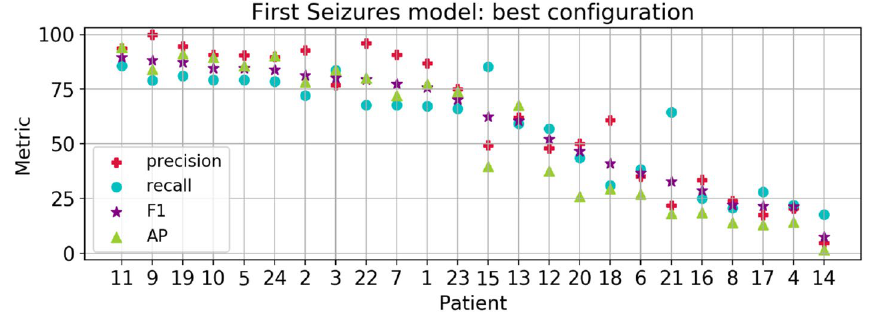
Figure 4. Results of the First Seizures model for all patients. Patients in x-axis are sorted by decreasing F-measure.